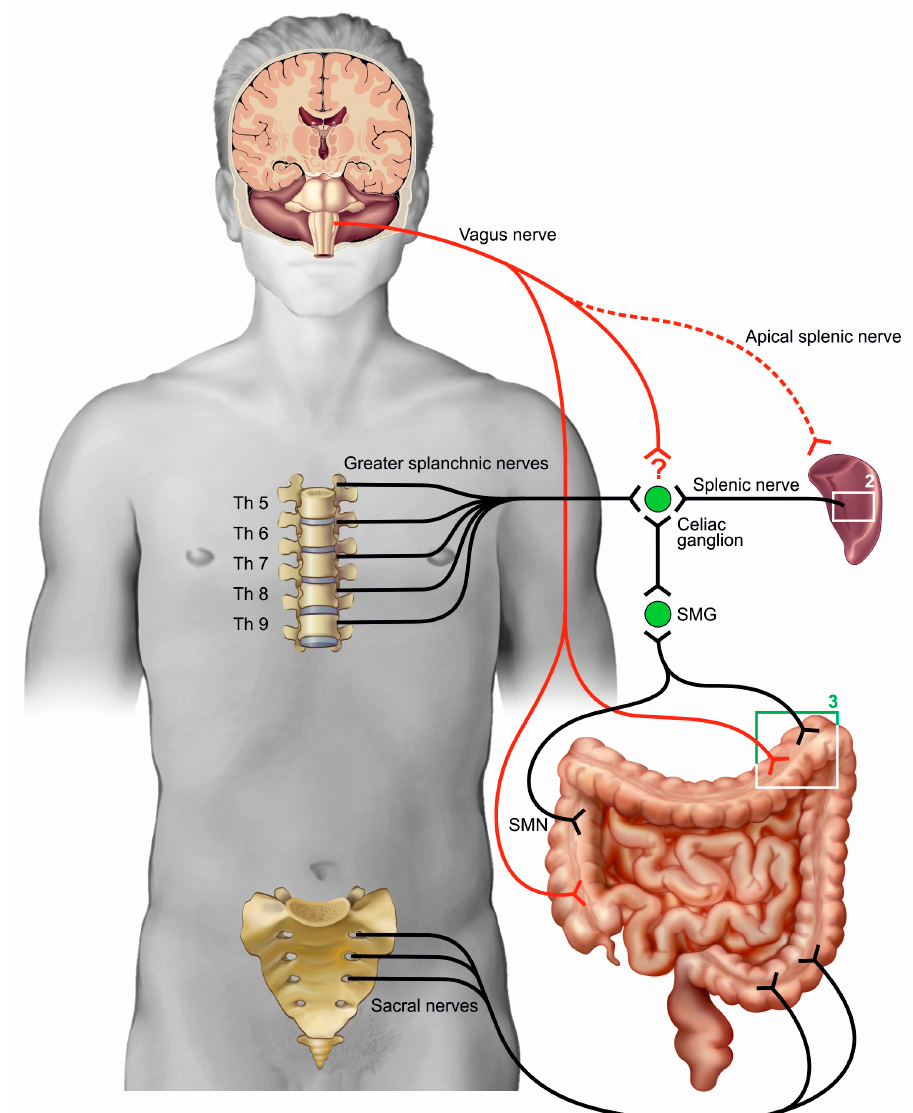
Figure 1. Schematic overview of the existing theories on the (cholinergic) anti-inflammatory pathway.